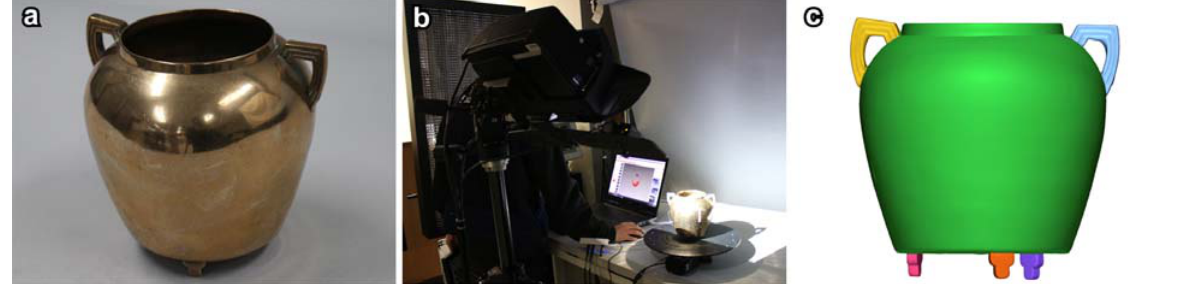
Figure 1. Occurrence and 3D scanning. (a) Original forms of ritual utensil. (b) Close-range 3D scan. (c) Polygon mesh model of ritual